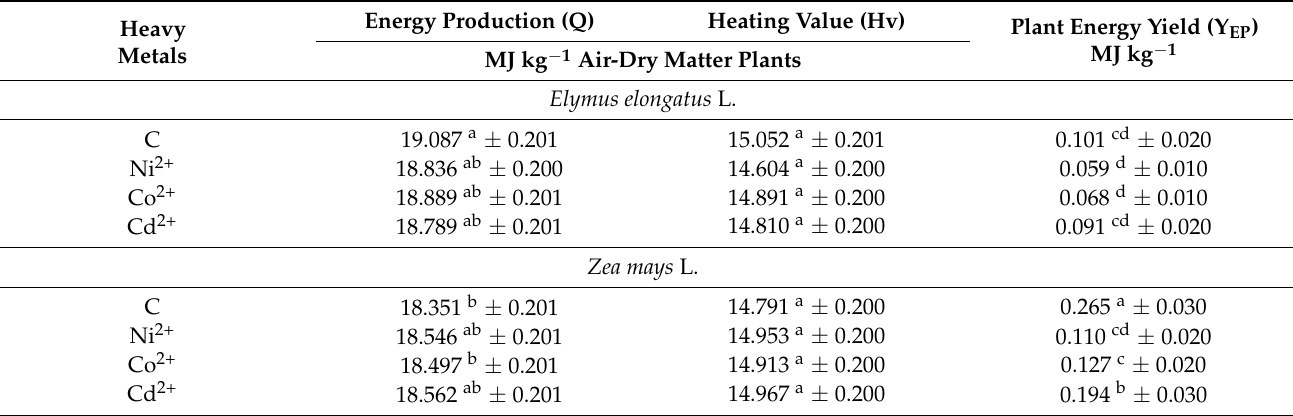
Table 1. Heat of combustion and heating value of Elymus elongatus L. and Zea mays L. grown on the soil polluted with heavy metals.